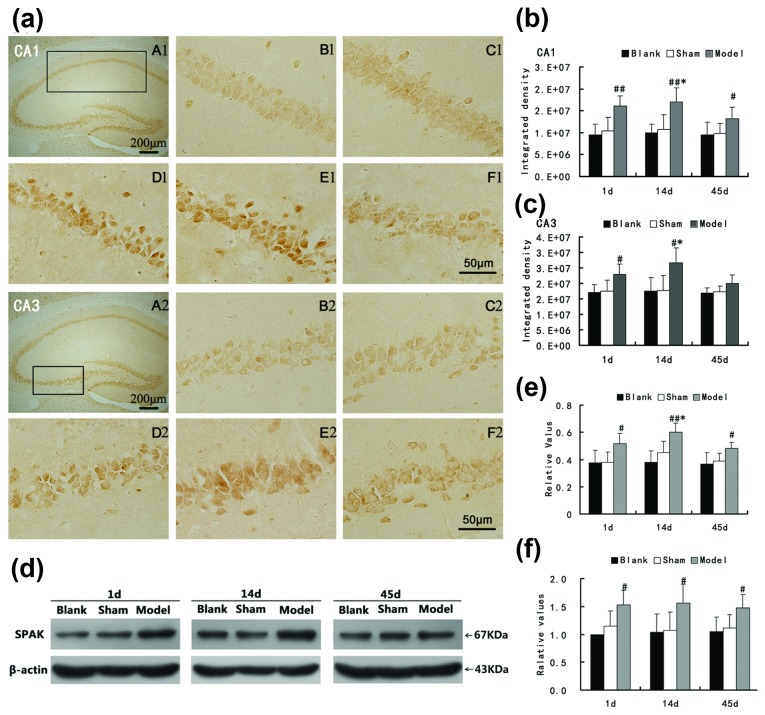
Expression of SPAK in mouse hippocampus at various stages of PISE.(a) (b), (c) Evaluation of SPAK expression in the CA1 and CA3 regions of mice hippocampi after PISE by immunohistochemistry. A: CA1 or CA3 region of hippocampus indicated with a box. B-F: The region selected in “A” from the blank group (B), sham group (C), day after PISE (D), day 14 after PISE (E), and day 45 after PISE (F). (d) (e) Evaluation of SPAK protein expression in mice hippocampi after PISE by Western blotting analysis. (f) Evaluation of SPAK mRNA expression in mice hippocampi after PISE by RT-PCR. Values are mean ± SD, #
P< 0.05 versus the blank and sham groups, ##
P<0.05 versus the blank sham groups, * P<0.05 versus day 1 and day 45 in the PISE-affected group. Scale bars in “F” apply to B-F.